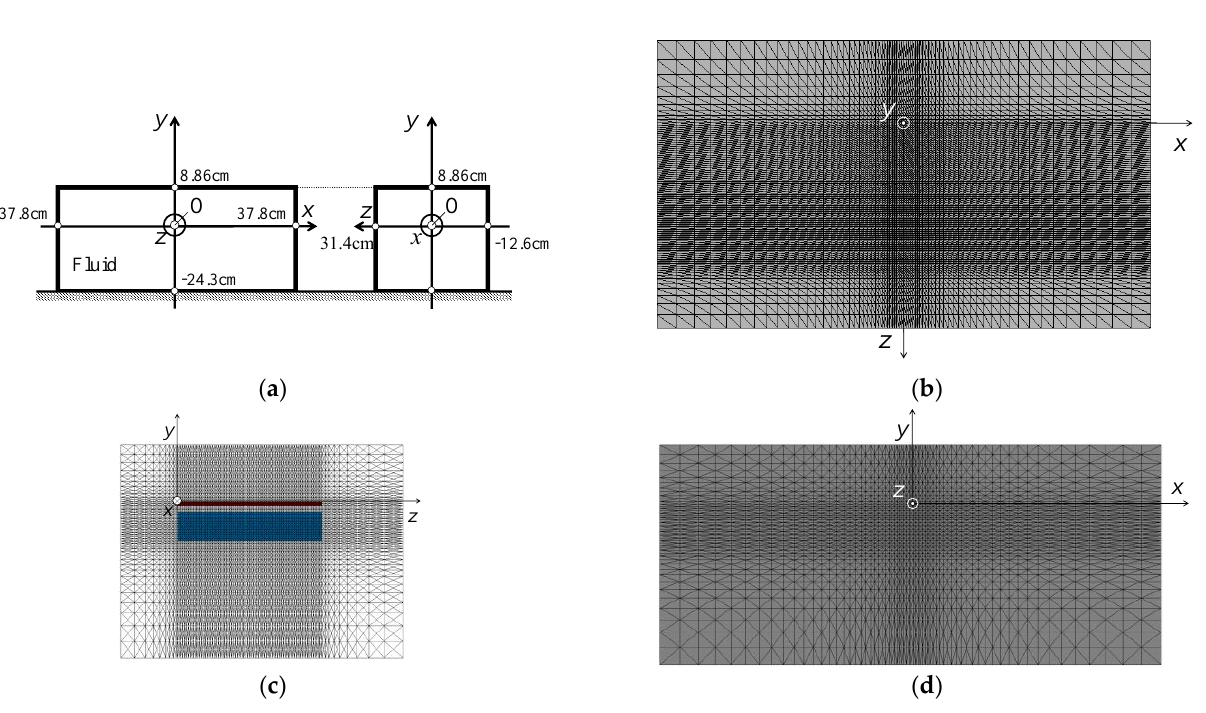
Figure 6. Geometry of the fluid domain and the employed mesh: ( a ) The geometry of the fluid domain (dynamically scaled); ( b ) The xz — plane view; ( c ) The yz — plane view, where the colored domain shows the wing’s mesh; ( d ) The xy — plane view. The number of fluid elements is 1,578,960 and the number of fluid nodes is 276,138.